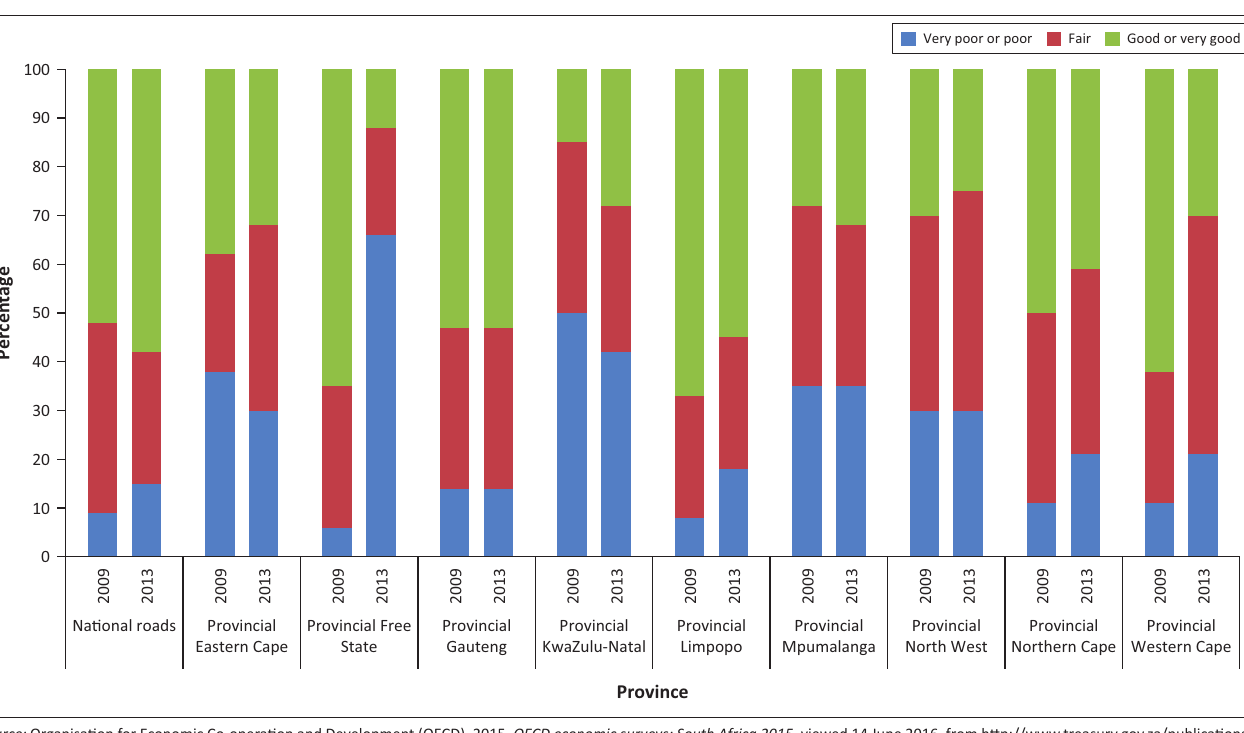
FIGURE 2: South Africa’s national and provincial road pavement conditions: 2009 versus 2013.